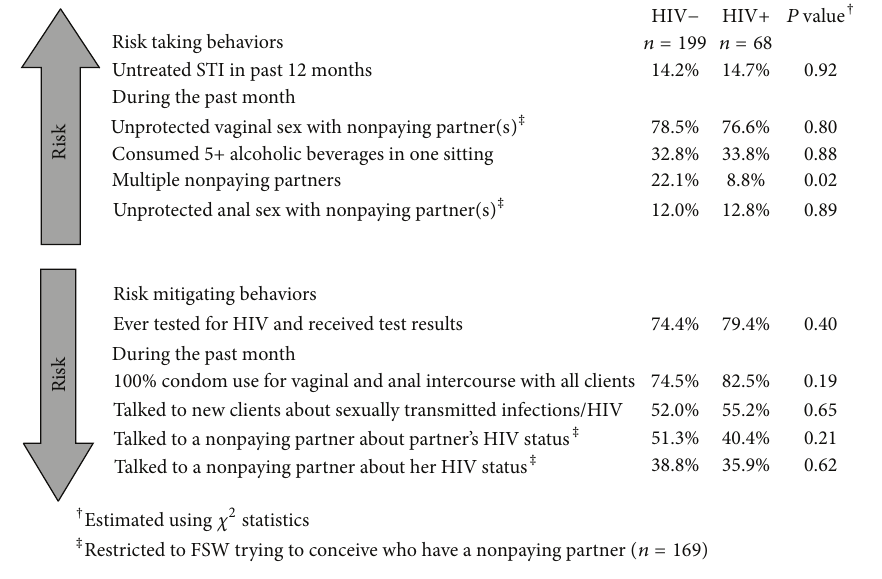
Figure 1: HIV prevention and risk behaviors among female sex workers trying to conceive (𝑛 = 267)